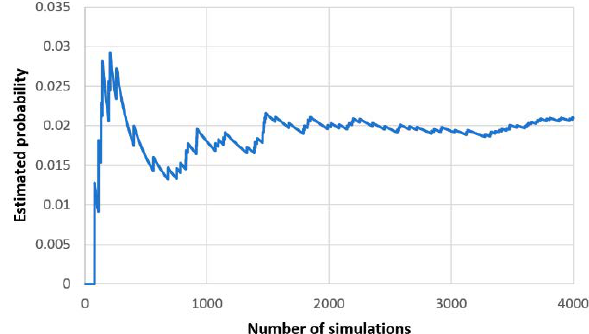
Figure 9. Comparison example between number of simulations and the estimated impact probability for a